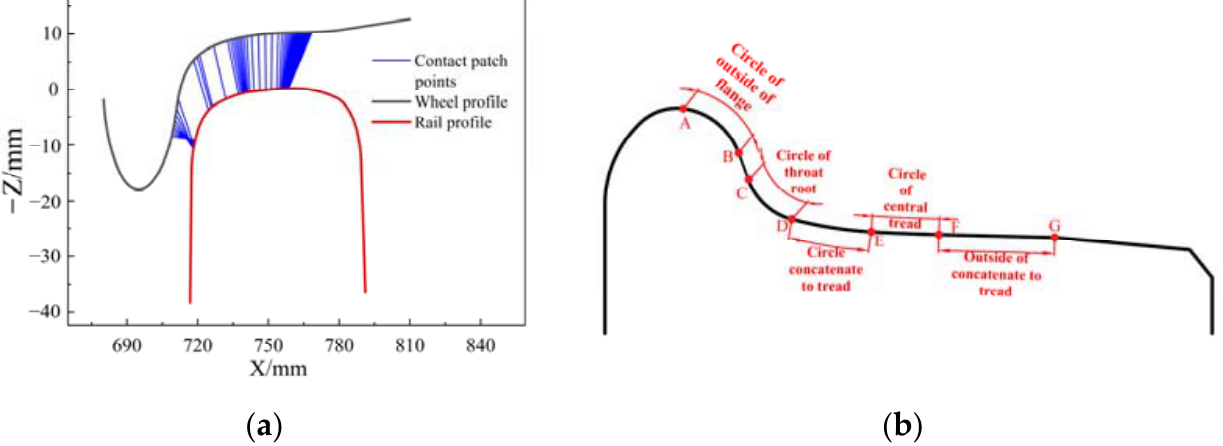
Figure 2. The measured curve in this study. ( a ) The distribution of wheel–rail contact points. ( b ) Each circular arc of the standard wheel profile.